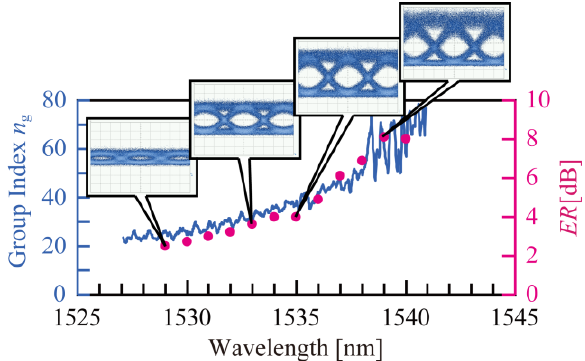
Figure 9. The n g spectrum of PCW device without lattice shifts and ER at 25 Gbps modulation. Set voltages were the same as those for Figure 5.